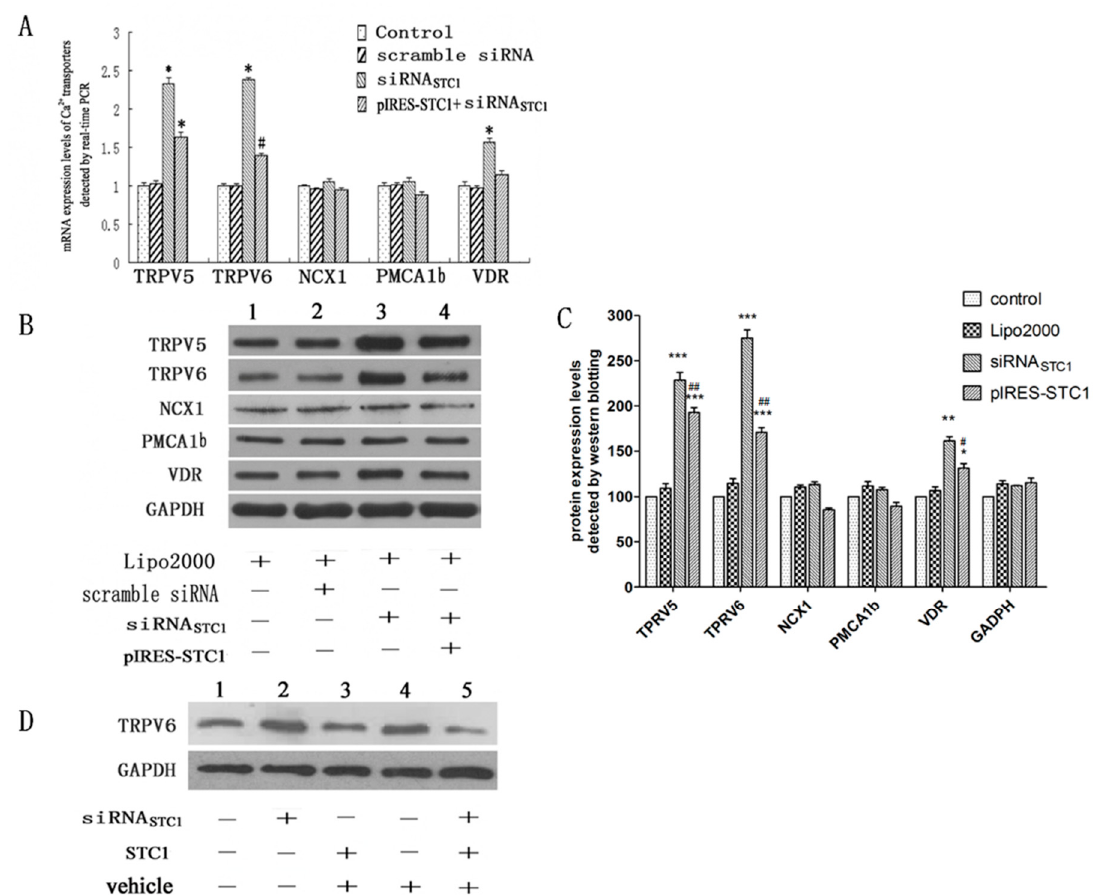
Figure 3. Analysis of epithelial Ca 2+ -transport protein expression in Caco2 cells after various treatments. ( A , B ) display quantitative PCR and western blotting analysis of the transport genes and proteins ( n = 4). Both gene expression and protein levels of TRPV5 , TRPV6 and VDR were enhanced following 48 h transfection with siRNA STC1 , and also with 48 h co-transfection with siRNA STC1 and pIRES-STC1 (with the exception of VDR ). Expression of NCX1 and PMCA1b revealed no significant change with inhibited expression of STC1 (* p < 0.01, # p < 0.05); ( C ) Densitometric quantification of the Western blotting shown in ( B ). Each bar represents the means ± SD. ( n = 3). *** p < 0.001, ** p < 0.01, * p < 0.05 compared with control; ## p < 0.01, # p < 0.05 compared with siRNA STC1 alone; ( D ) Western blotting analysis of TRPV6 protein expression. TRPV6 protein levels increased following transfection with siRNA STC1 , and slightly decreased after a 4 h treatment with 100 ng/mL rhSTC1. However, treatment with rhSTC1 following siRNA STC1 transfection down-regulated the expression of TRPV6 . All the experiments were replicated for three times.